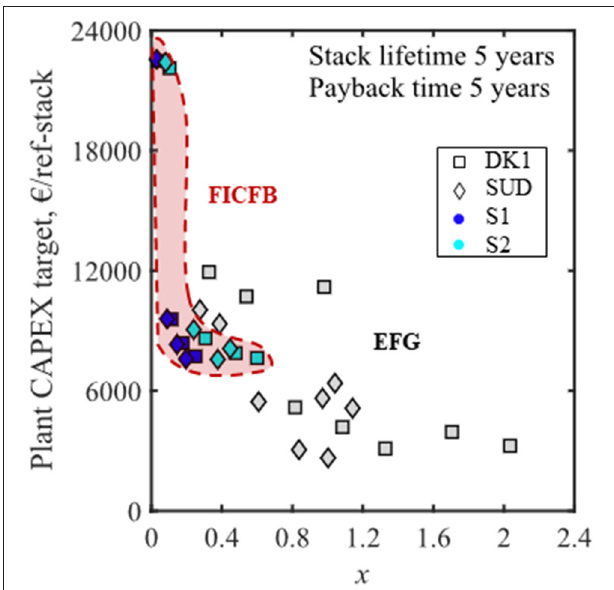
FIGURE 12 | Plant CAPEX target recalculated by considering the revenue from SNG sale to market, considering the price of SNG being 0.6 e /kg ( IEA, 2019).